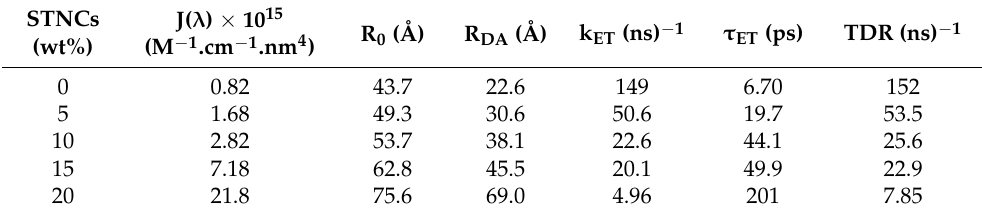
Table 2 . Energy Transfer Parameters of PFO/10 wt% MEH ‐ PPV hybrid thin film with various con ‐ tent of STNCs.